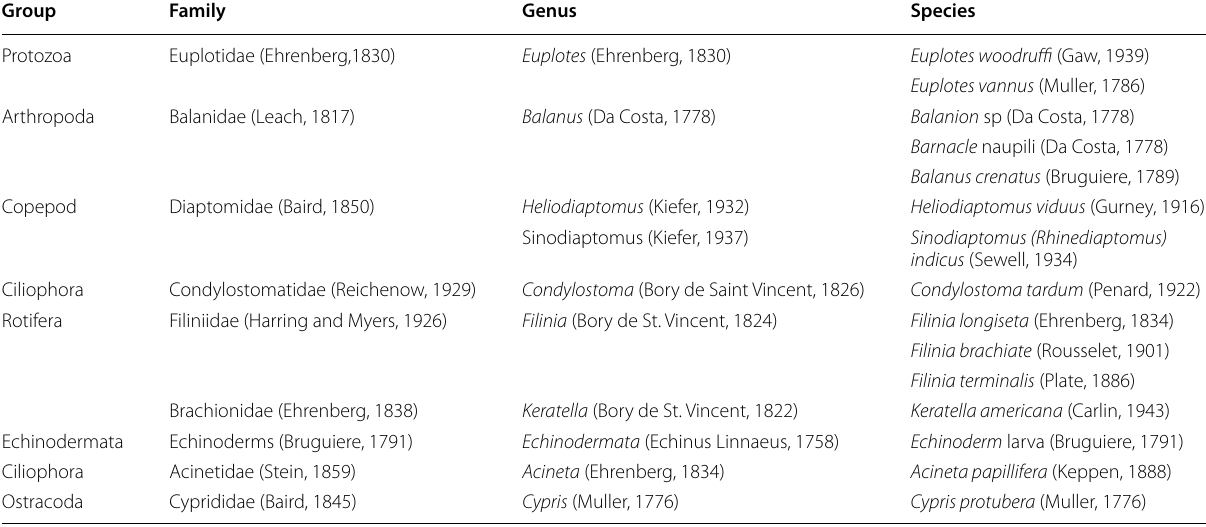
Table 6 The occurrence of phytoplankton and zooplankton during the study period at station 1 S.